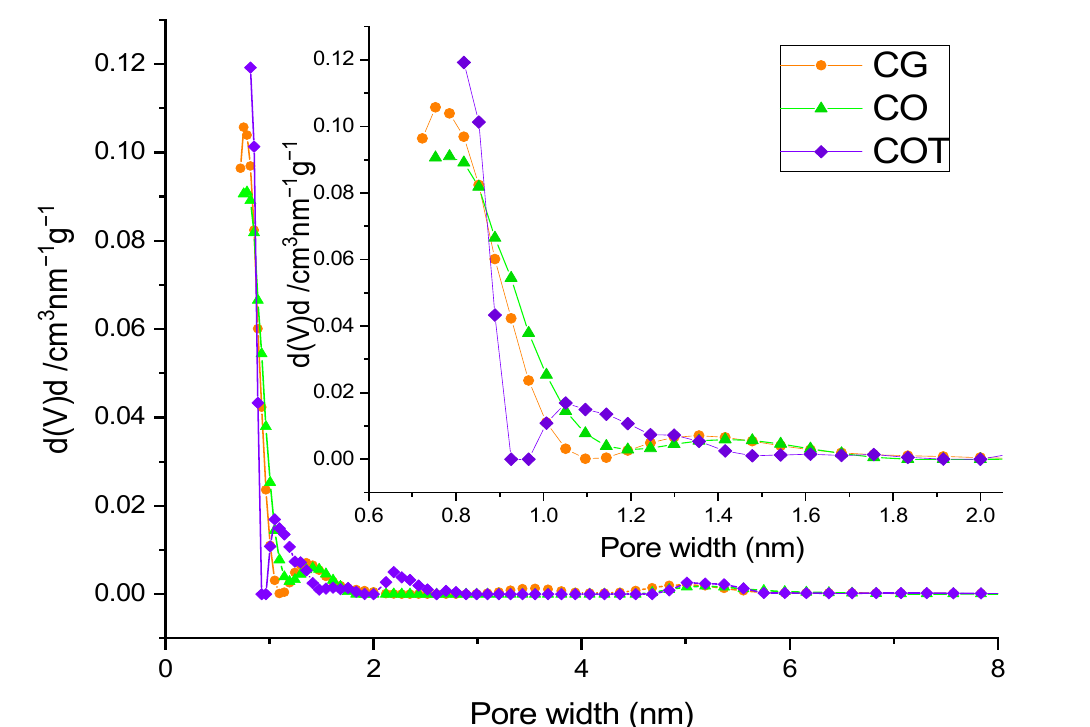
Figure 2. Pore volume variation as a function of pore width obtained by the QSDFT model (slit- cylinder pore geometry) for activated carbon samples with a zoom plot for the micropore area (upper right).